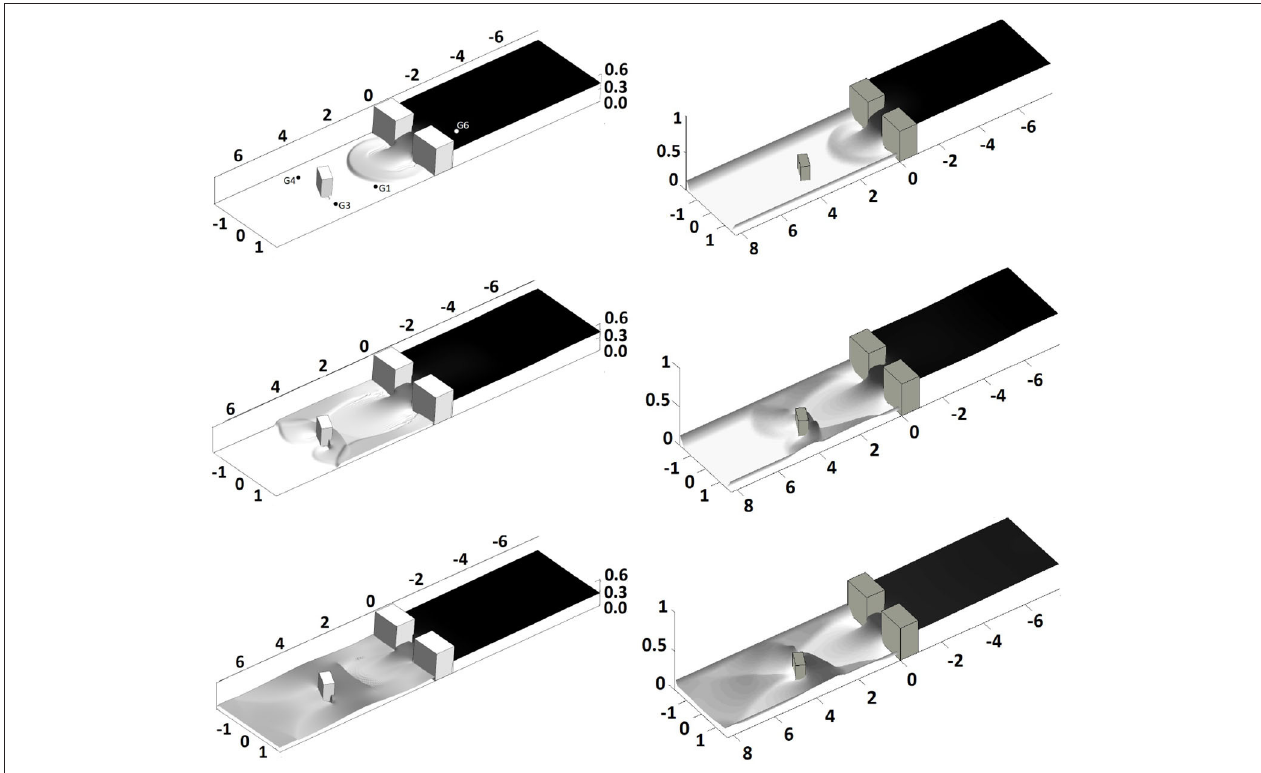
FIGURE 5 | Test case II. Free surface at t = 1 s , t = 3 s , t = 10 s . Left : DBE results; right : numerical results from Soares-Frazão and Zech (2007) ; top-left panel shows gauges